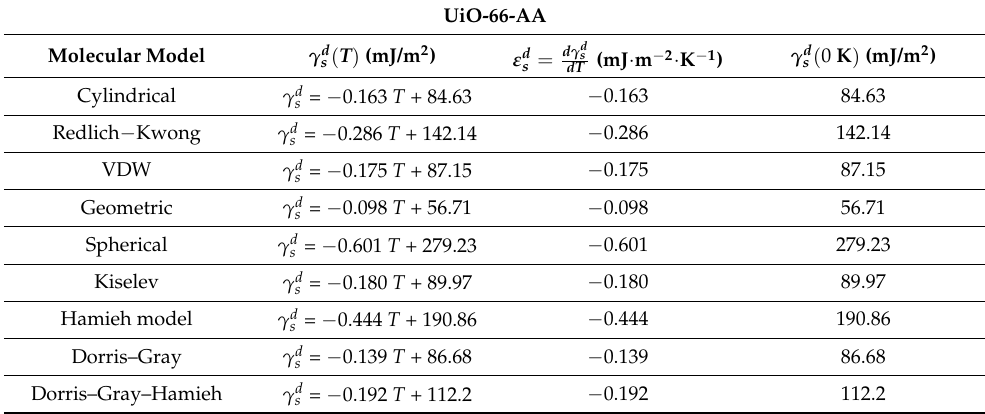
Table 3. Equations γ d s ( T ) of UiO-66-AA surface, the dispersive surface entropy ε d s , and the extrapo- lated values γ d s ( 0 K ) by using the different molecular and thermal models.